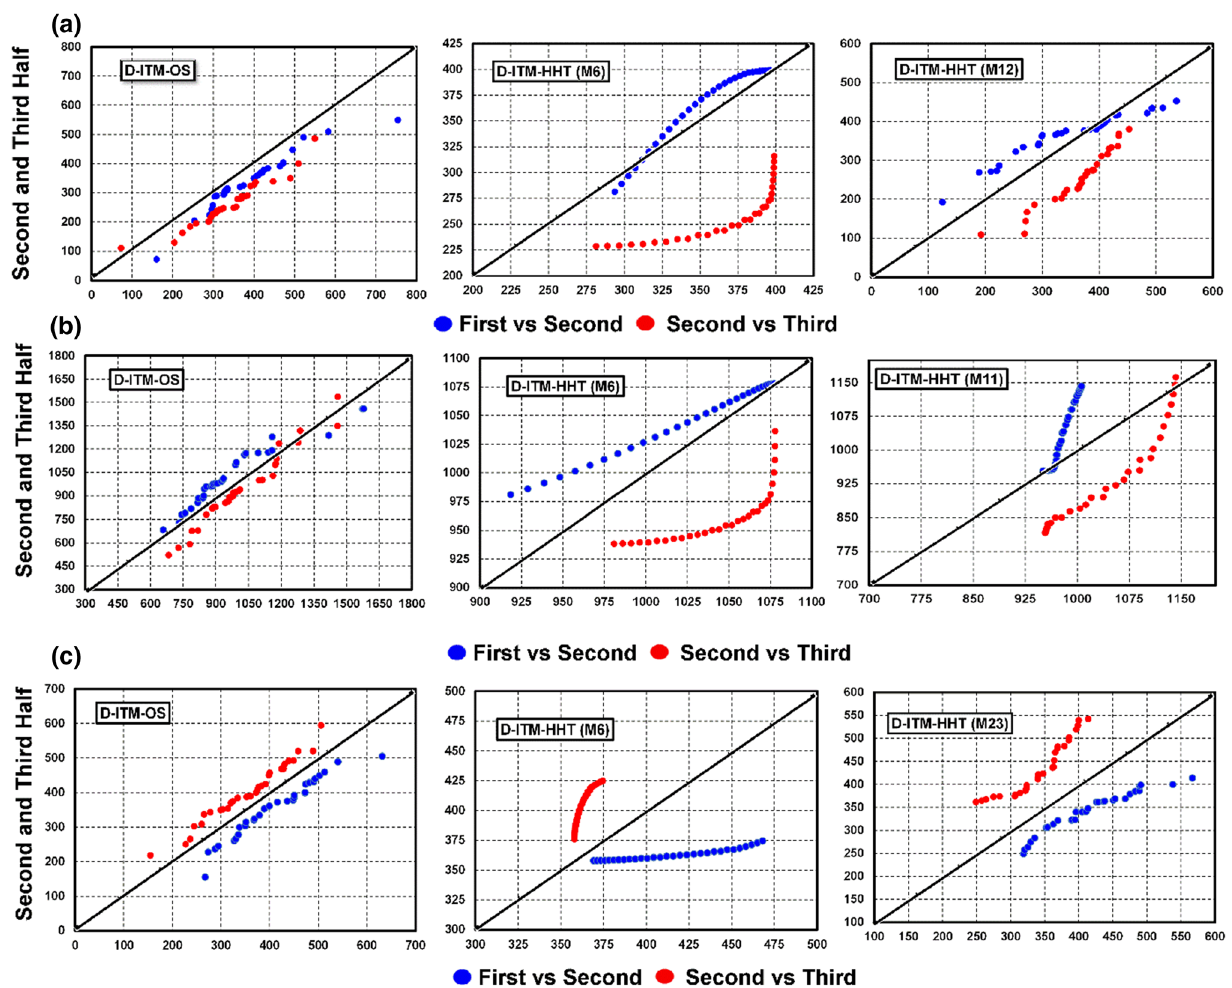
Fig. 8 Representations and comparison of the results of the application of the Double-innovative trend method (D-ITM) on the original series (left side) and some proposed models using HHT (hybrid approach) at a Oued Taria, b Azazga, and c Ain Beida